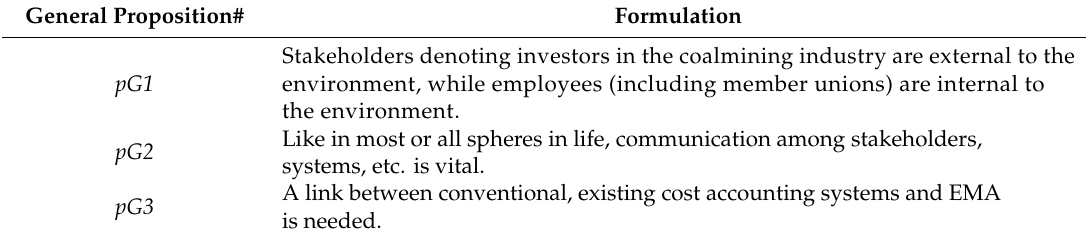
Table 1. List of general propositions.